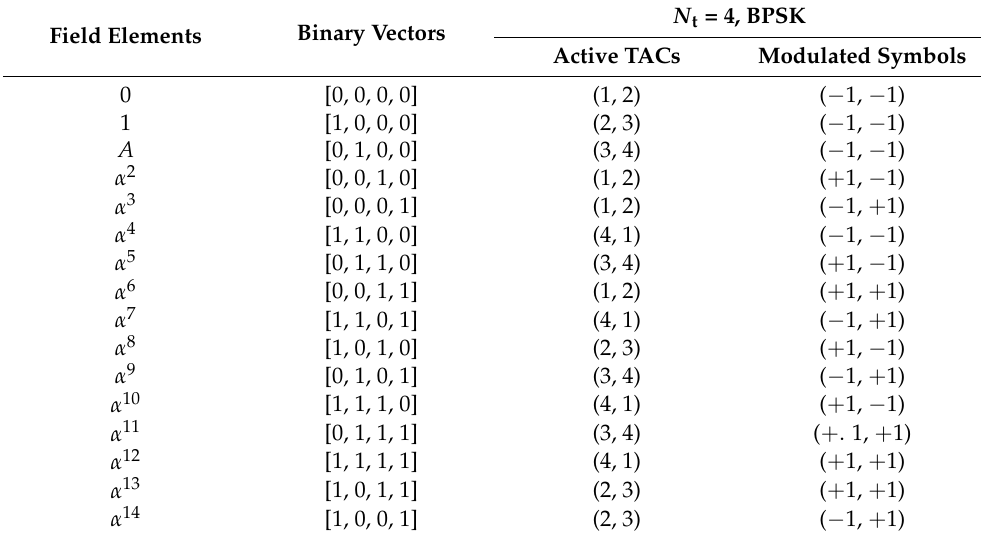
Table 1. Mapping procedure for STBC-SM with codes over the field F 16 . Field